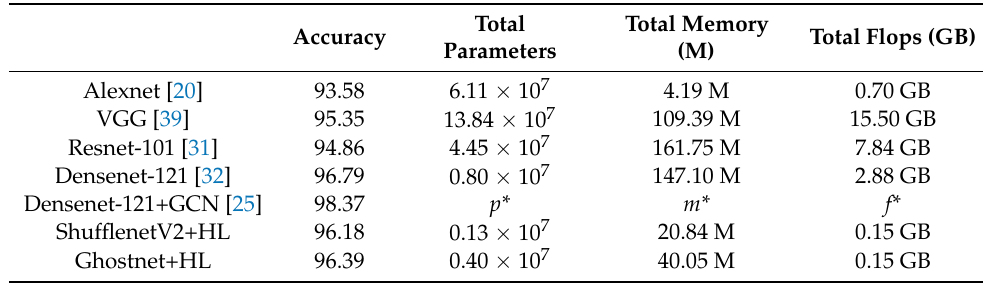
Comparison results of the proposed method with existing methods for the SIPaKMeD